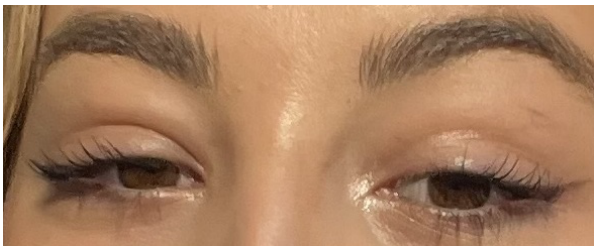
Figure 1. Hoagland sign in our patient on the day of presentation (day 10 of symptoms).